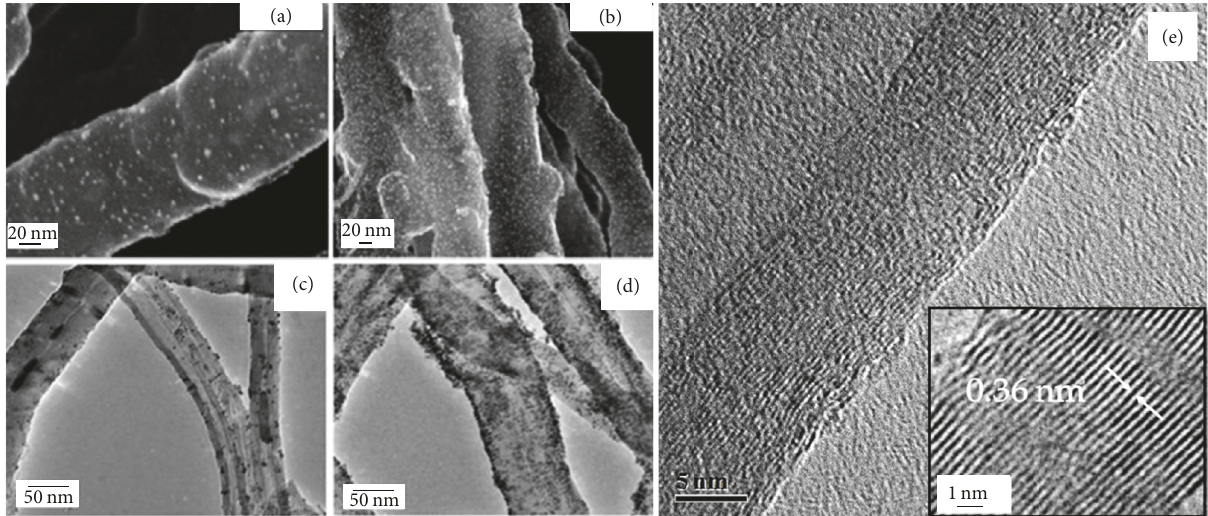
Figure 2: SEM image of MWCNTs with (a) Pt at 5 wt% and (b) Pt at 30 wt%. TEM image of MWCNTs with (c) Pt at 5 wt% and (d) Pt at 30 wt%. (e) In HRTEM image of an isolated CNT, the inset shows its multiwall nature.